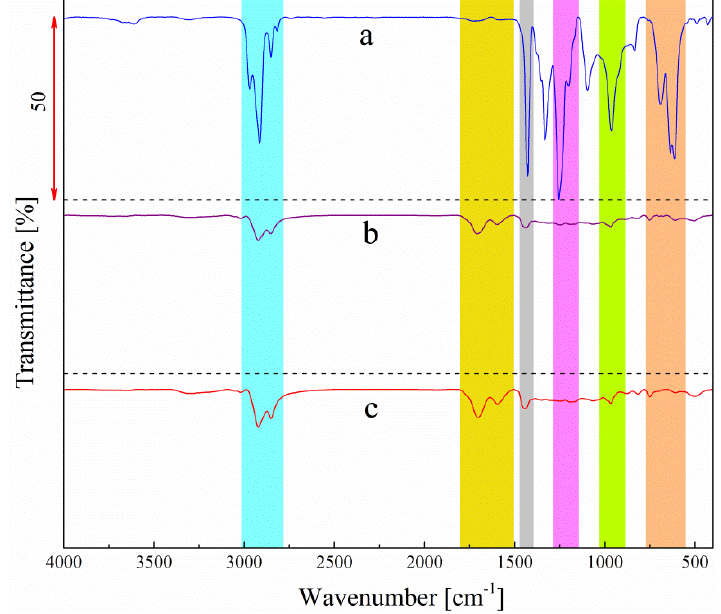
Figure 4. FT-IR spectra of ( a ) PVC; residues obtained by the HT dechlorination of PVC at 240 °C after 60 min in ( b ) 0%, and ( c ) 1% sodium hydroxide.